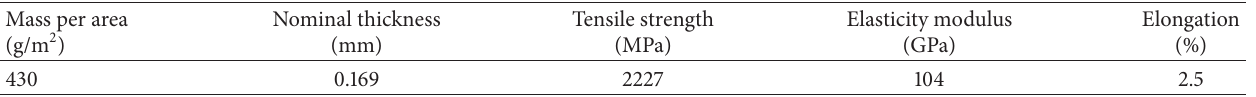
Figure 2: Failure modes of specimens (a) SU-1, (b) SHG-2, (c) SHG-3, (d) LU-1, (e) LHG-2, and (f) LHG-3. Table 2: Mechanics properties of GFRP.